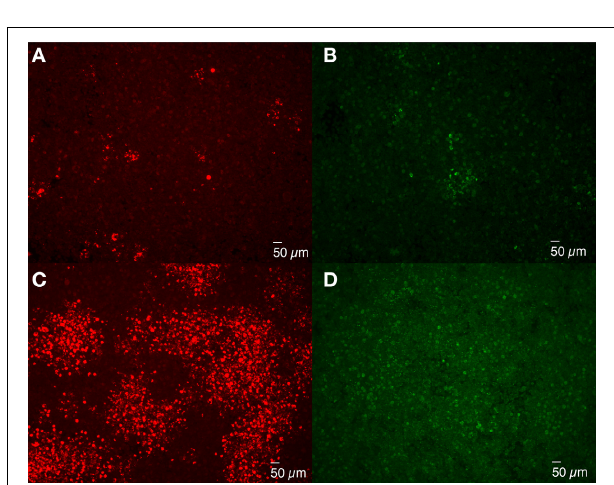
FIGURE 7 | Extracellular cell-to-cell dissemination of Brucella . J774.A1 macrophages were infected with 16M (cid:2) manBA (A,C) or 16M (B,D) at an MOI of 0.1. An agarose overlay was added at 1h p.i. along with fresh DMEM supplemented with (A,B) or without (C,D) 50 μ g/ml of gentamicin. Following an additional 4 days of incubation, the cells were fixed and stained to visualize intracellular Brucella via IFA. Scale bar, 50 μ